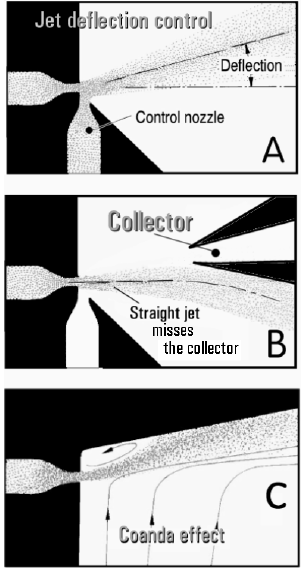
The most important among fluidic no-moving-part flow control principles are deflection of jets. A – Jet is directed by momentum interaction with the flow coming from the control nozzle. An amplifier has a collector capturing more or less the deflected jet, leading it to the output terminal, C – Often used Coanda effect keeps the jet deflected by attachment to a wall even in absence of any control